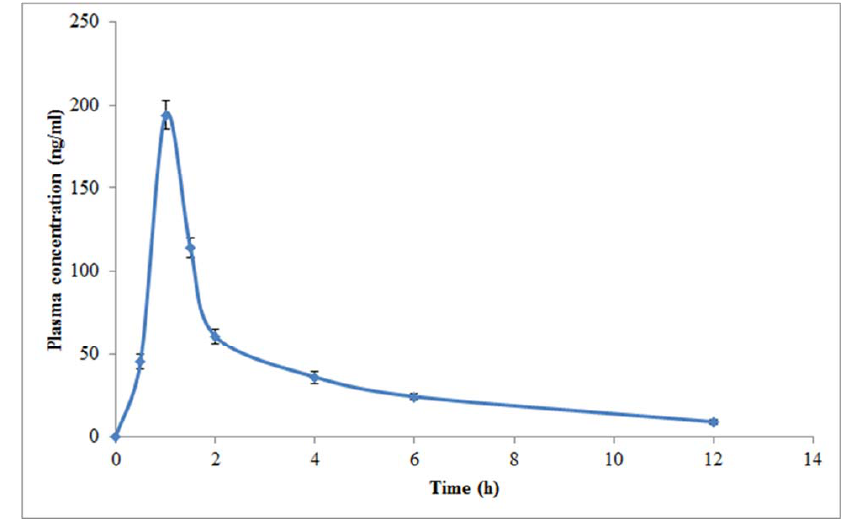
Figure 5. Plasma concentration ‐ time profile curve of DLX after a single dose oral (20 mg/kg) administration in rats (mean ± SD; n = 6).